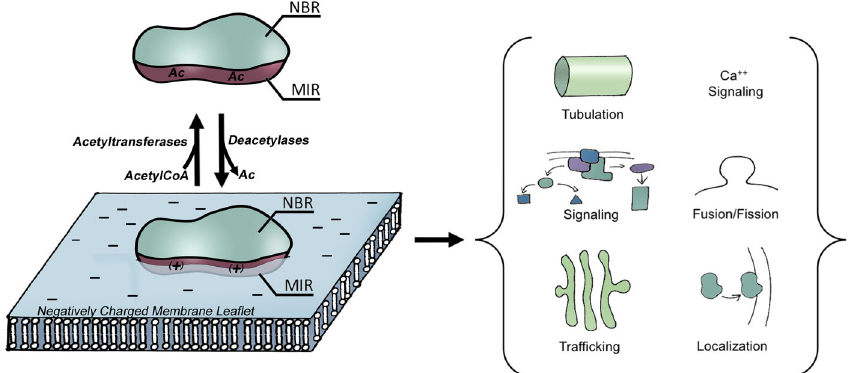
Fig. 9 Proposed model of effects of lysine acetylation on protein-membrane interactions. Peripheral membrane proteins carry out numerous vital cellular functions (right) via interactions with cellular membranes (bottom left). Membrane-interaction region (MIR) and non-binding region (NBR) are colored mauve and teal, respectively. Acetylation alters protein-membrane interactions by neutralizing membrane-interacting lysines of peripheral membrane proteins (top left). The plus signs indicate positively charged lysines, whereas Ac indicates acetylated, neutral